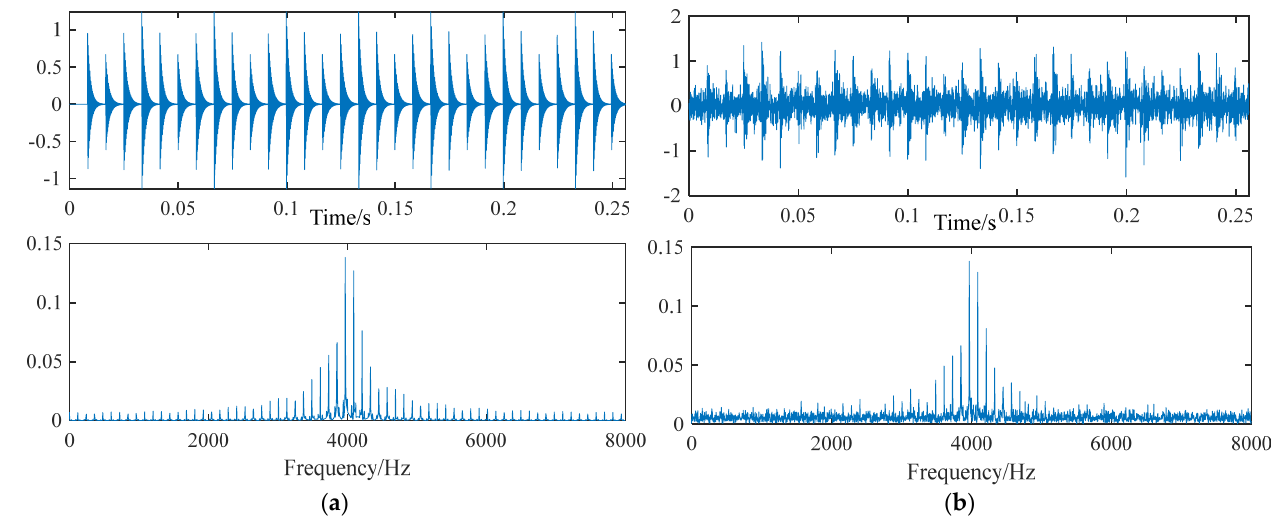
Figure 2. Simulated signals: ( a ) pure signal waveform and spectrogram ( b ) simulated signal wave- form and spectrogram.